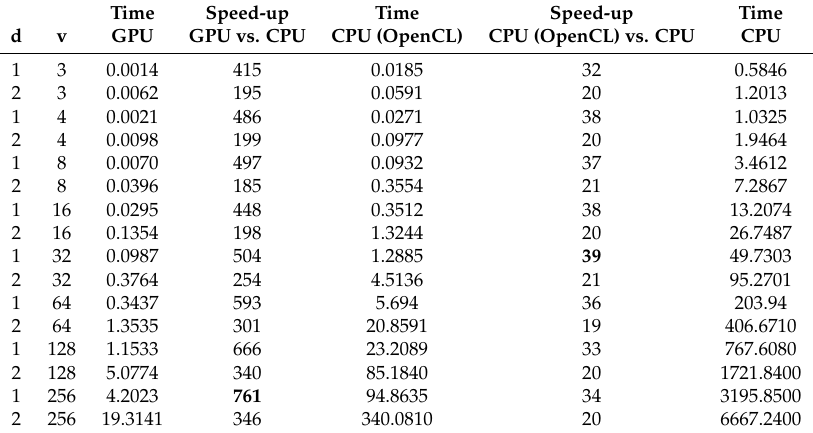
Table 3. Performance of the NLM algorithms applied to any band of the Oil Spill image (size 1200 × 256) for different values of the similarity ( d , column 1) and search ( v , column 2) windows. Computational time of the portable OpenCL code run on GPU and CPU platforms is shown in columns 3 and 5, respectively. Moreover, column 7 reports the computational time of the sequential algorithm for the CPU. The speed-up of the portable parallel algorithm with respect to the sequential one run on the GPU and on the CPU is also shown in columns 4 and 6, respectively. Cases with the highest speed-up are highlighted in